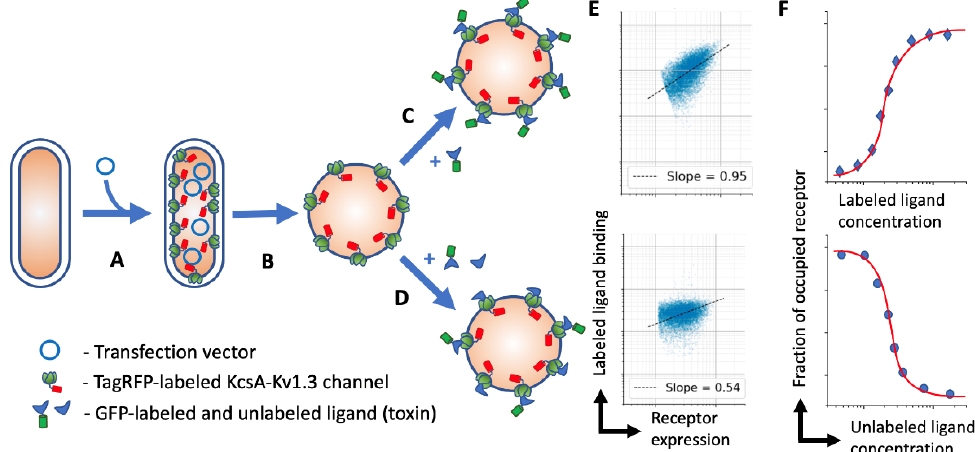
Figure 1. Schematic representation of the assay pipeline. ( A ) E. coli are transfected with an expression vector coding KcsA-Kv1.3-RFP chimeric channel; ( B ) on the day of the experiment, the E. coli envelope is disrupted with a lysozyme/EDTA solution to make the channel accessible for water-soluble compounds; ( C , D ) spheroplasts are incubated with either a labeled ligand or its mixture with an unlabeled (same or other) ligand; ( E ) spheroplasts are analyzed by flow cytometry and the amount of fluorescent ligand binding per unit of expressed receptor (fraction of occupied receptor) is derived. ( F ) The data on the fraction of occupied receptors is fitted with appropriate binding curves and dissociation constants are calculated.